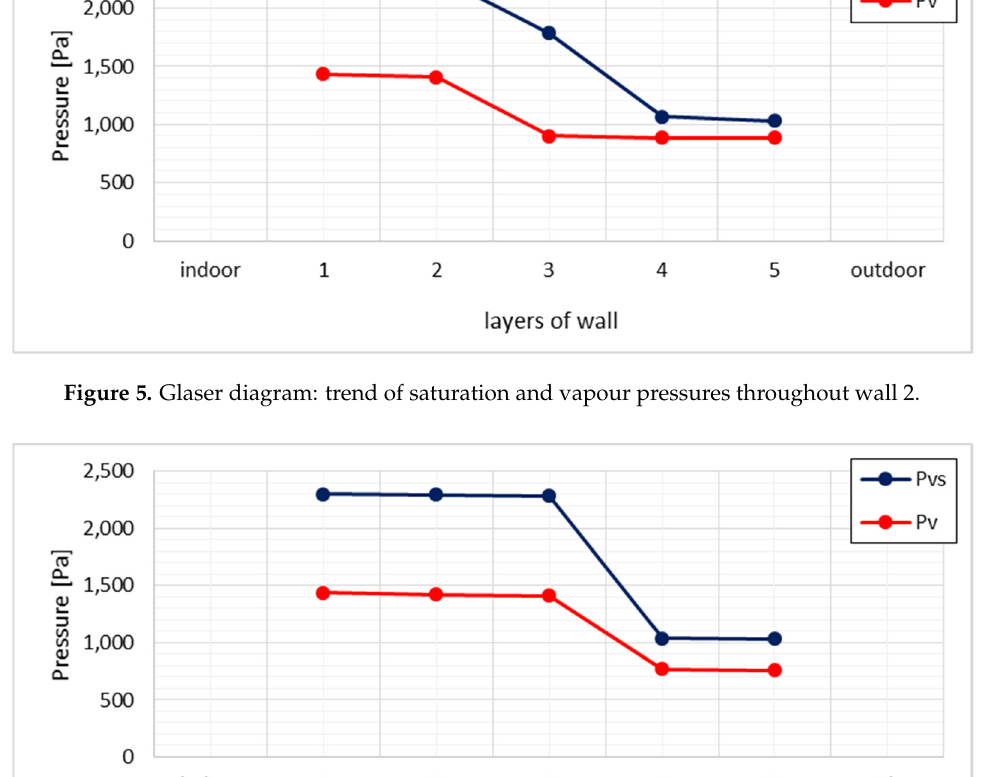
Figure 4. Glaser diagram: trend of saturation and vapour pressures throughout wall 1.